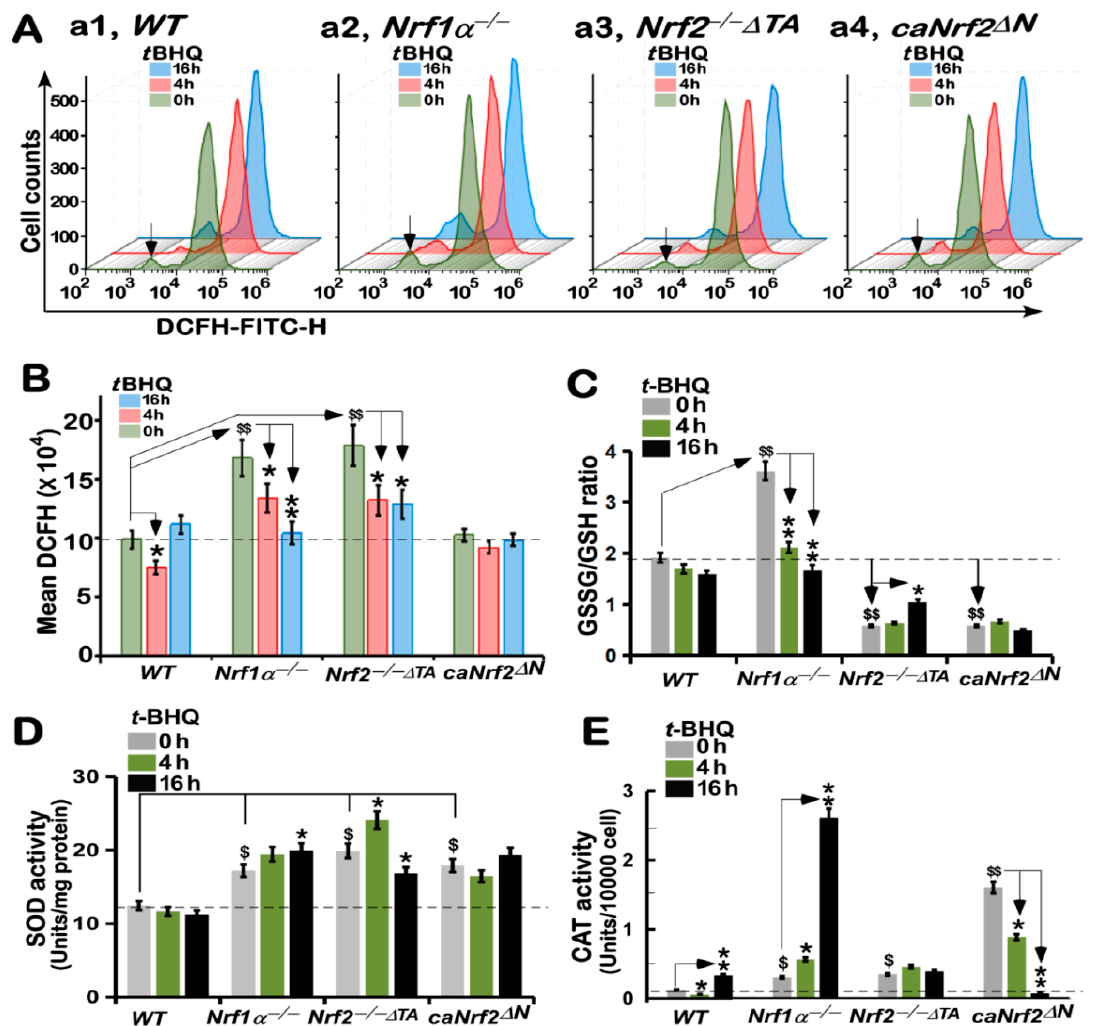
Figure 5. Altered levels of ROS, GSSG and GSH, along with ROS-scavenging activity of SOD and CAT, induced by t BHQ. ( A ) Experimental cells of WT , Nrf1 α − / − , Nrf2 − / − ∆ TA , and caNrf2 ∆ N were allowed for treatment with 50 µ M t BHQ or not for different time periods (i.e., 0, 4, 16 h). Thereafter, the cells were subjected to a flow cytometry analysis of intracellular ROS by the DCFH-DA fluorescent intensity. The resulting data were further analyzed by FlowJo 7.6.1 software, as shown in the column charts ( B ). ( C ) The intracellular GSH and GSSH levels, together with two ROS-scavenging activities of SOD ( D ) and CAT ( E ), were measured according to the introduction of relevant kit manufacturers. All the experiment was repeated three times, each of which was performed in triplicates. Their statistic significances were determined as described in Section 2. Of note, $$, p <0.01, and $, p < 0.05 indicate significant differences calculated by comparing each basal value of [ Nrf1 α − / − ] T0 , [ Nrf2 − / −Δ TA ] T0 , and [ caNrf2 Δ N ] T0 with that of [ WT ] T0 , while both * p < 0.05 and ** p < 0.01 denote significant differences of those values from each of cell lines treated by t BHQ for 4 h (i.e., [X] T4 ) or 16 h (i.e., [X] T16 ) versus its untreated [X] T0 value in the same group.